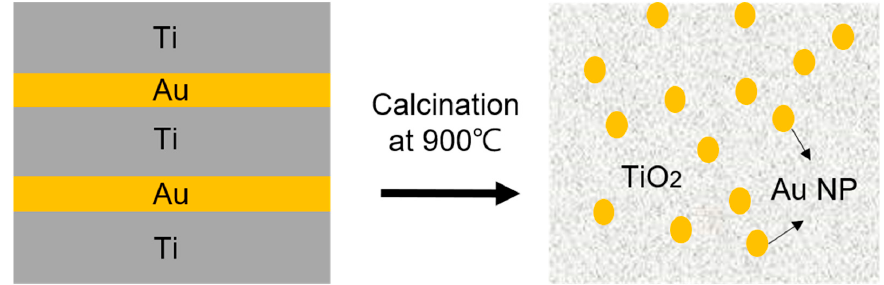
Figure 1. Schematic of example multilayered film stack to achieve uniformly distributed Au NP in the TiO 2 matrix after calcination.